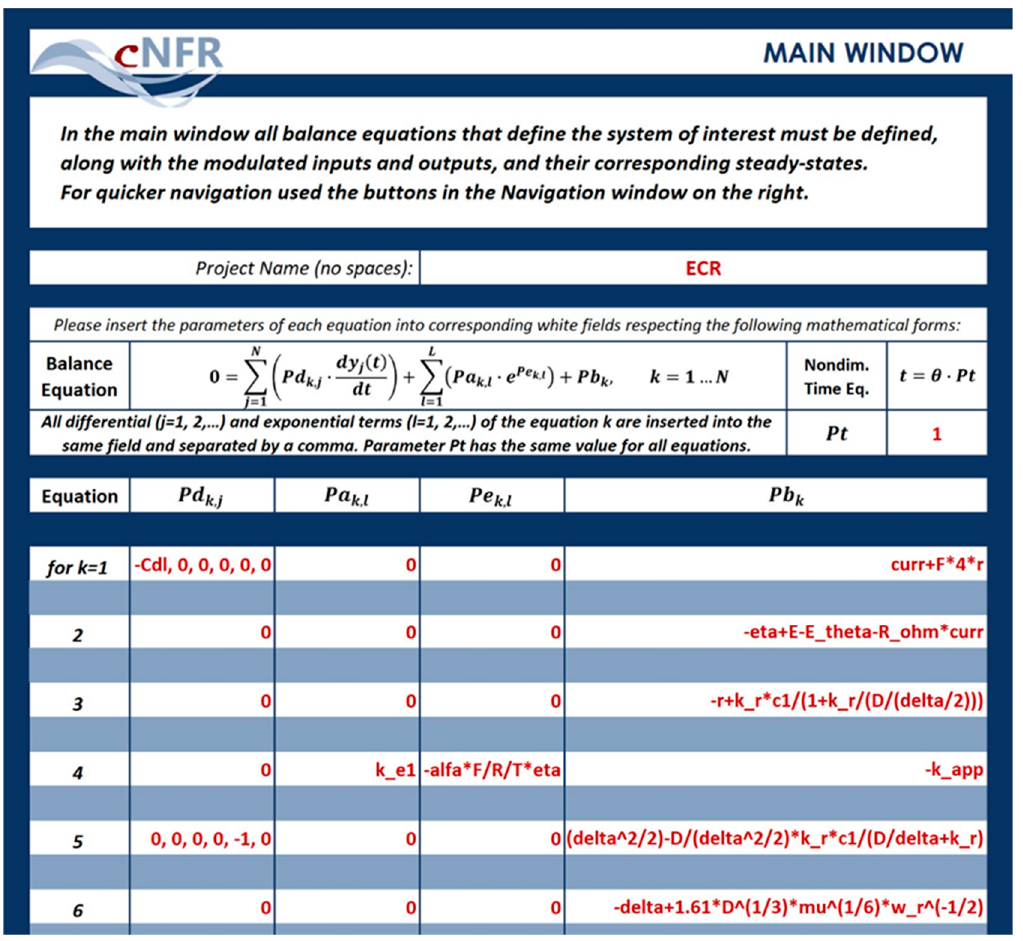
Figure 13. Equations field in cNFR Main Window for Example 2: ECR.